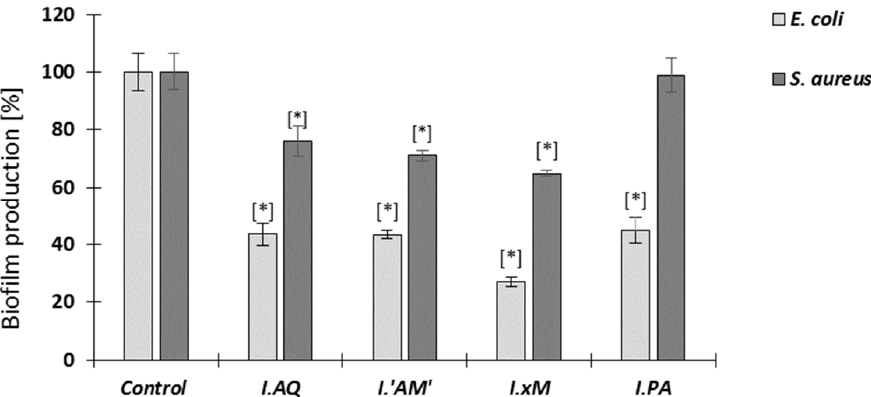
Figure 4. Influence of Ilex spp. extracts (at 1/2 MIC concentration) on biofilm production E . coli and S . aureus after 24 h. The control is bacteria without extracts; mean ± SD, n = 3; * statistically different from the control p < 0.05. Legend: I.PA — I. paraguariensis ; I.AQ — I. aquifolium ; I.’AM’ — I. aquifolium ‘Argentea Marginata’; I. × M — I. × meserveae ‘Blue Angel’.